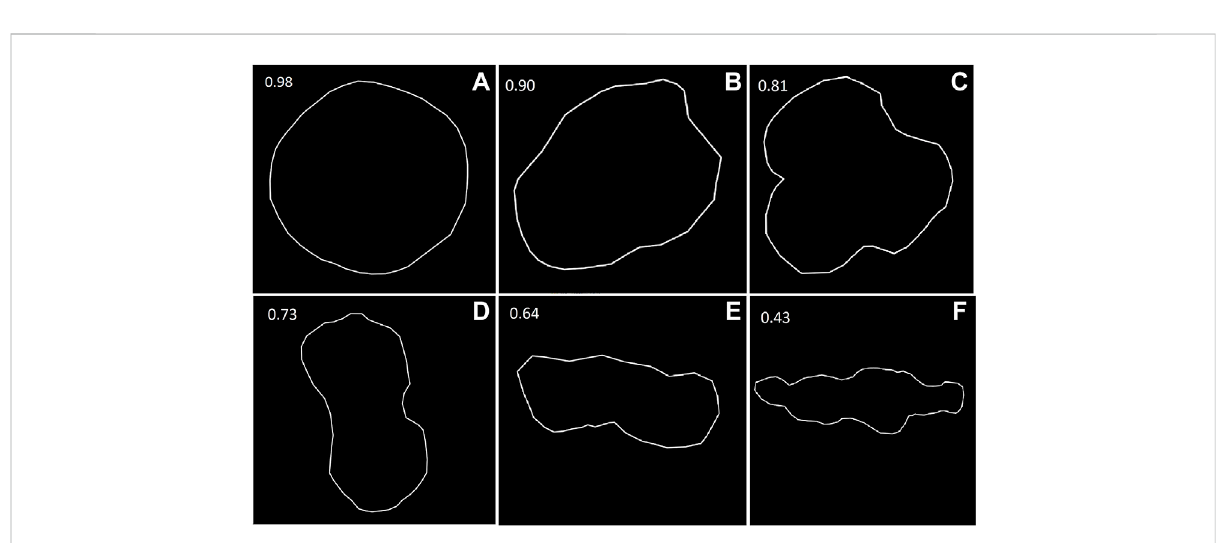
FIGURE 7 Changes in isoperimetric circularity (IC) from real examples. (A) Dry Maar, Diamond Craters, Oregon, United States. (B) DCOR-0012 unnamed maar, Diamond Craters, Oregon, United States. (C) Clover Maar, Diamond Craters, Oregon, United States. (D) DCOR-0009 collapse feature, Diamond Craters, Oregon, United States. (E) Laki-010 spatter landform, Laki, Iceland. (F) Laki-002, Laki, Iceland. Dry maar represents a circular outline (0.98) with Laki-002, a spatter landform, represents an elongate endmember (0.43). IC is an exponential parameter, thus a seemingly small change in value is a large change in overall